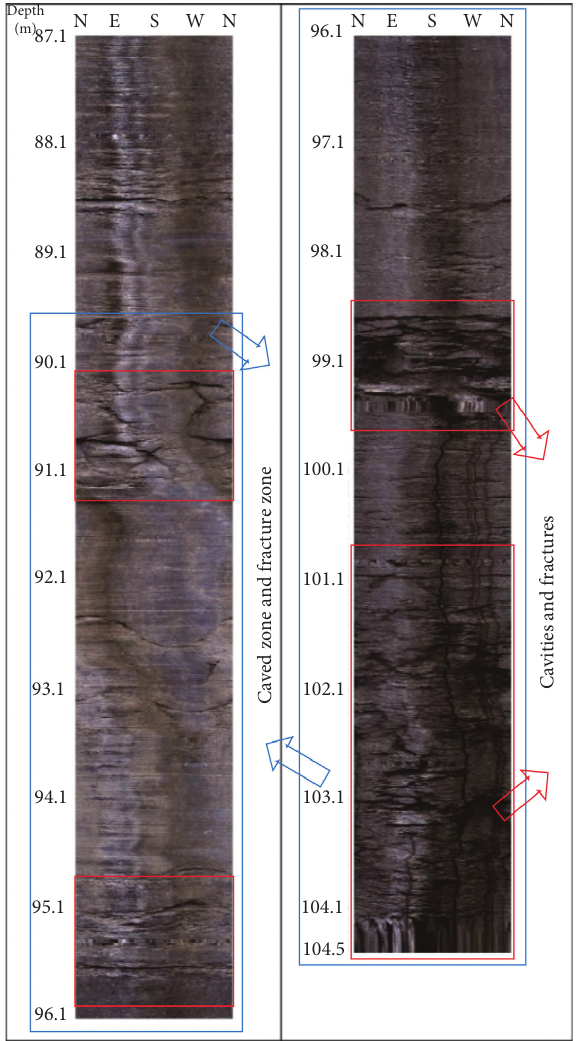
Figure 3: Parts of TV images of the K6